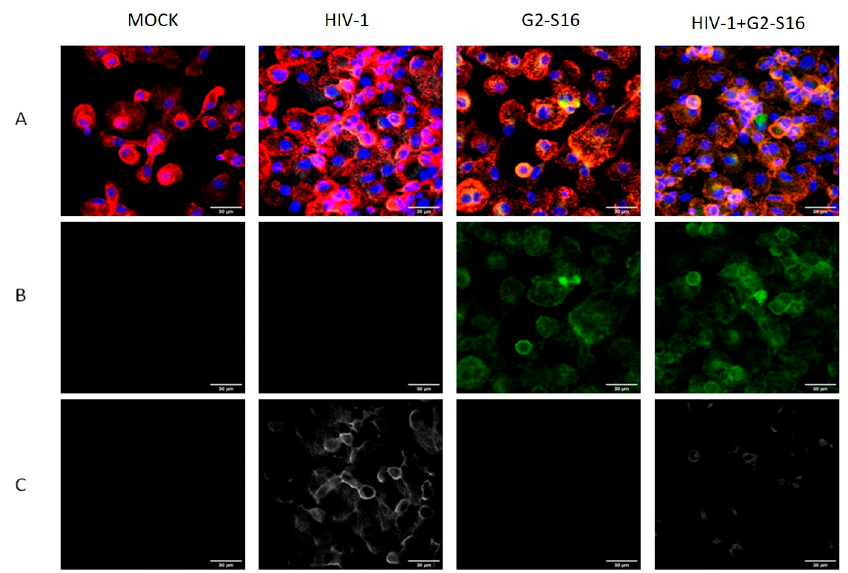
Figure 3. Representative confocal images of HIV-1 infection in MDMs and T cell co-cultures. Human monocytes and T lymphocytes were isolated from the same buffy coat. Monocytes were differentiated to MDMs. After differentiation, MDMs were treated with G2-S16-FITC for 2 h and washed with glycine (pH 3) to detach all non-internalized dendrimer in the cell membrane and washed 3 times with PBS. After washes, MDMs were infected with 6 ng/µL per 1 × 10 6 cells of HIV-1 and co-cultured with T lymphocytes for 48 h. Supernatant was gently discarded and cells were mounted to perform confocal microscopy. Confocal images were taken 48 h after co-culture with T cells. ( A ) Merge ( B ) G2-S16-FITC ( C ) HIV- 1 P24. Red: cell membrane. Blue: cell nuclei. Green: G2-S16/G2-S16-FITC dendrimer. White: HIV-1 p24 protein Scale bar: 30µm. Representative images of 3 independent experiments are shown.